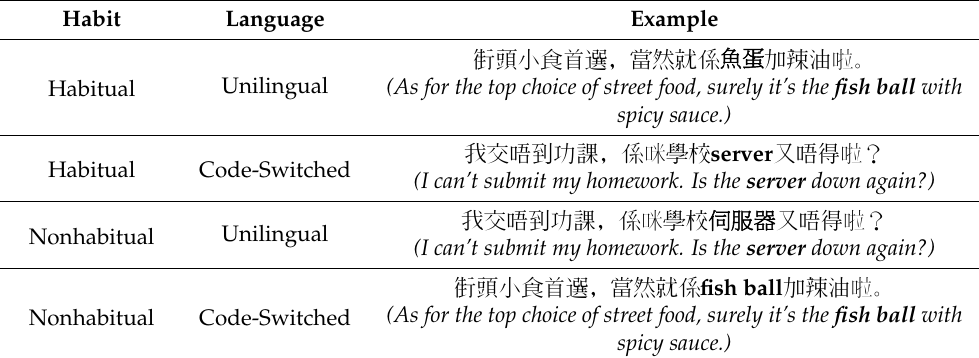
Table 2. Examples and the translation of the four conditions in the experiment. The critical word was bolded in each example for illustration only. No special formatting for the critical words was made in the actual experiment. English translation is provided in italic.